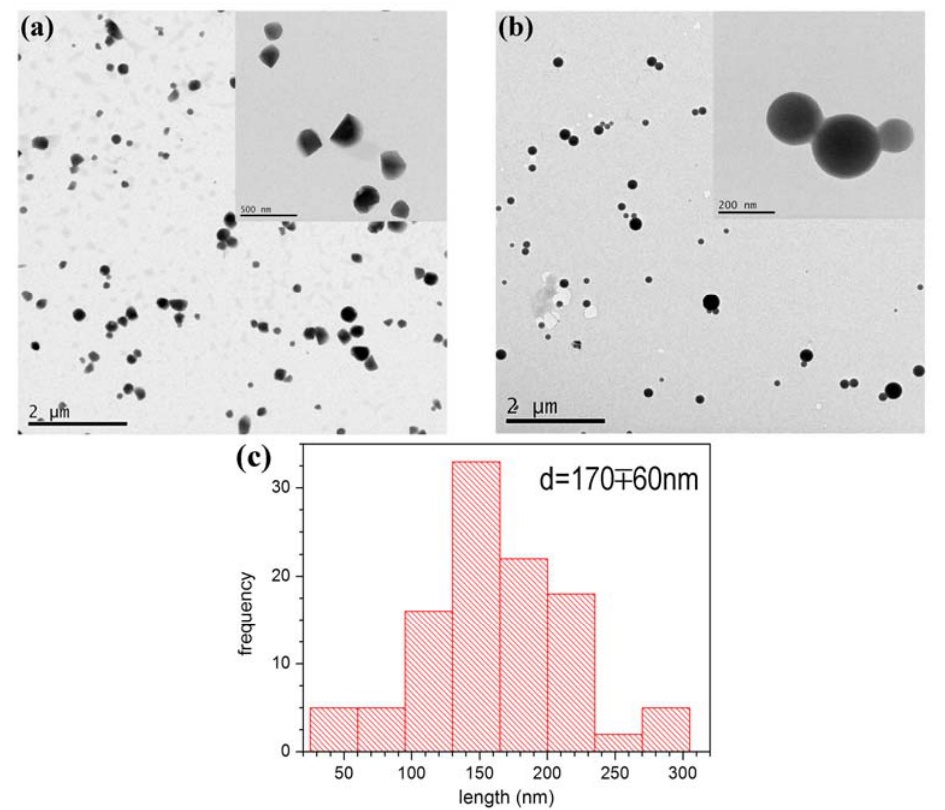
Figure 5. Transmission electron micrographs of ( a ) CA-CH (blank) and ( b ) CA-CH-H micellar nanodispersions stained with osmium tetroxide aqueous solution for enhancing the contrast. Insets in the pictures report magnified areas of each sample. ( c ) Particle-size distribution of sample CA-CH-H 2